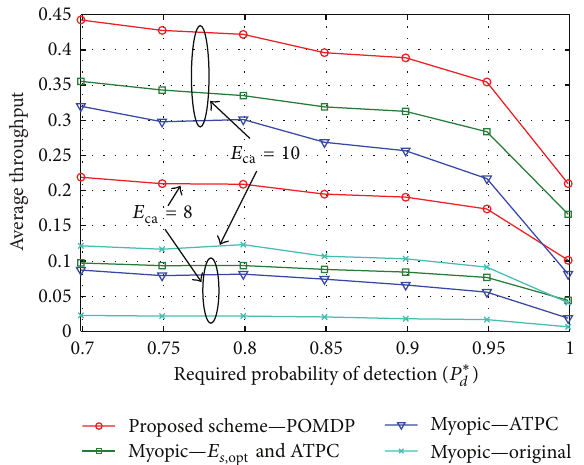
Figure 8: Average throughput of the proposed scheme in compari- son with Myopic schemes for values of 𝐸 𝑒 ℎ = 2 mean